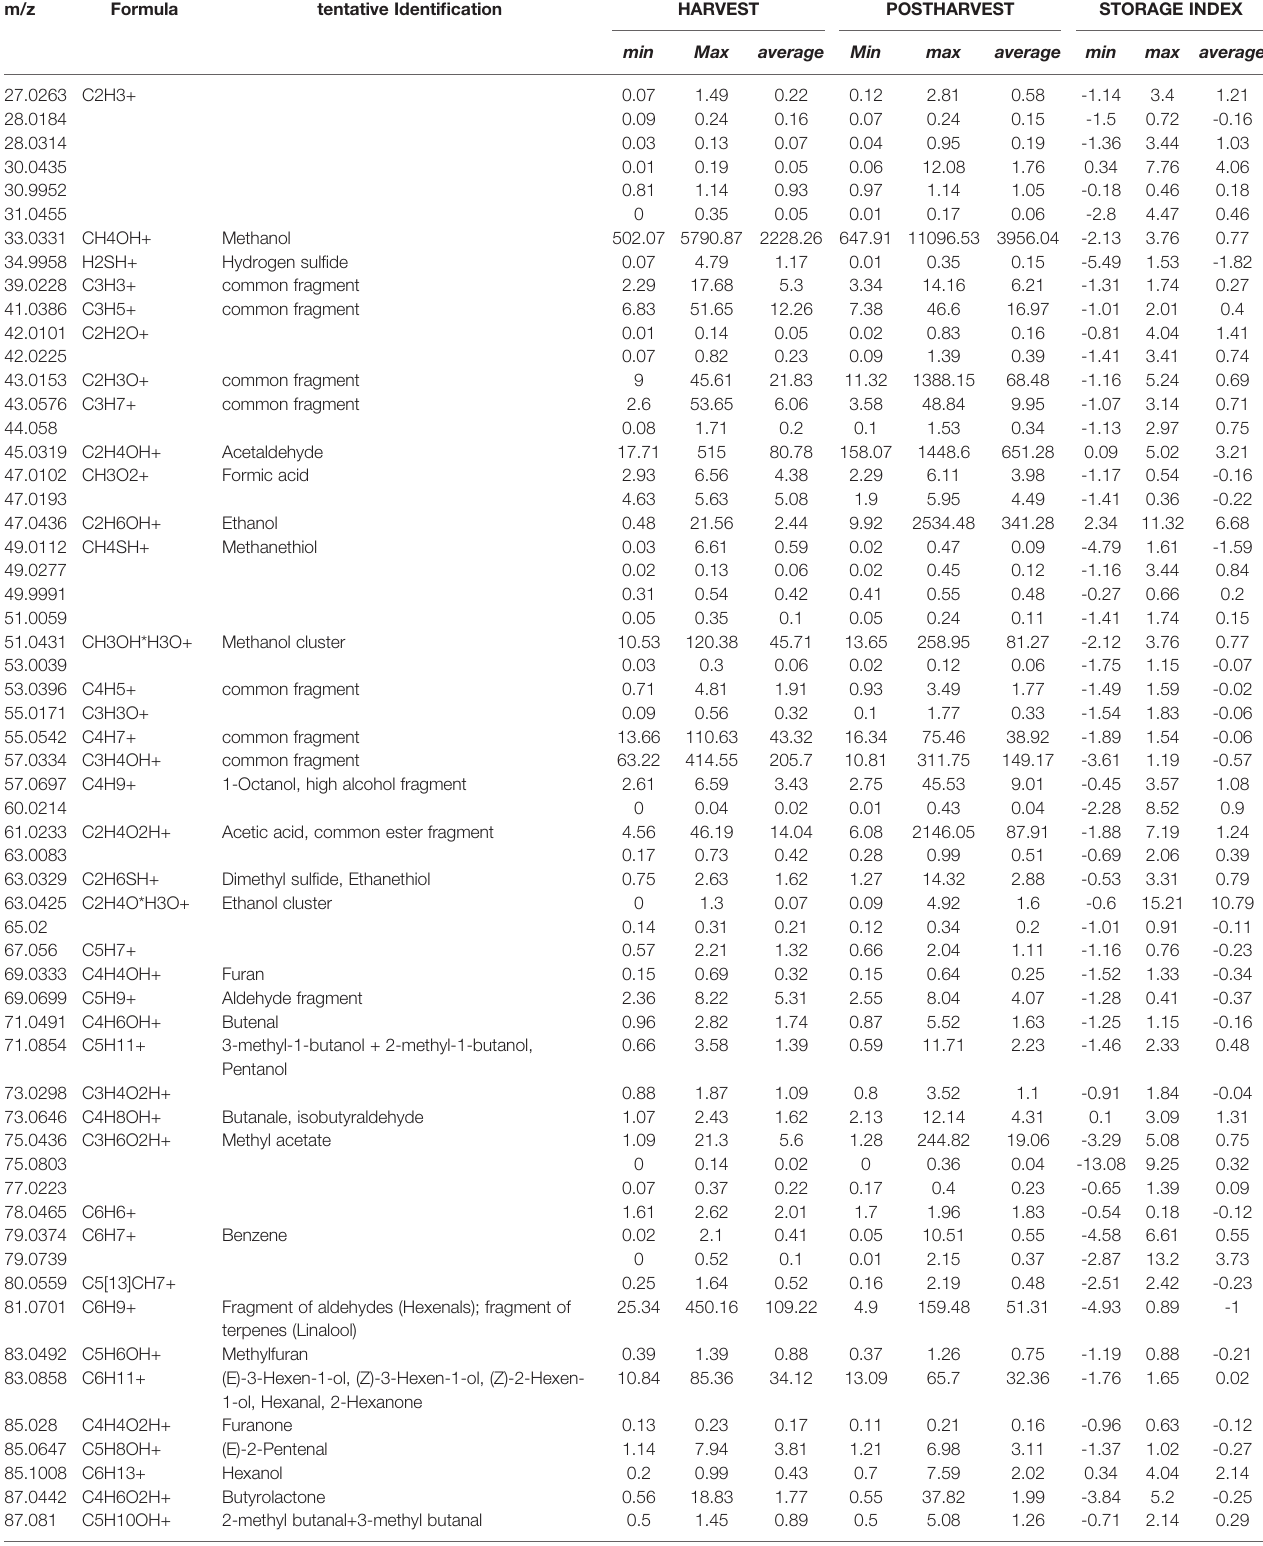
TABLE 3 | Volatile organic compounds detected by PTR-ToF-MS at harvest and after storage, over 46 Vaccinium spp. cultivars.